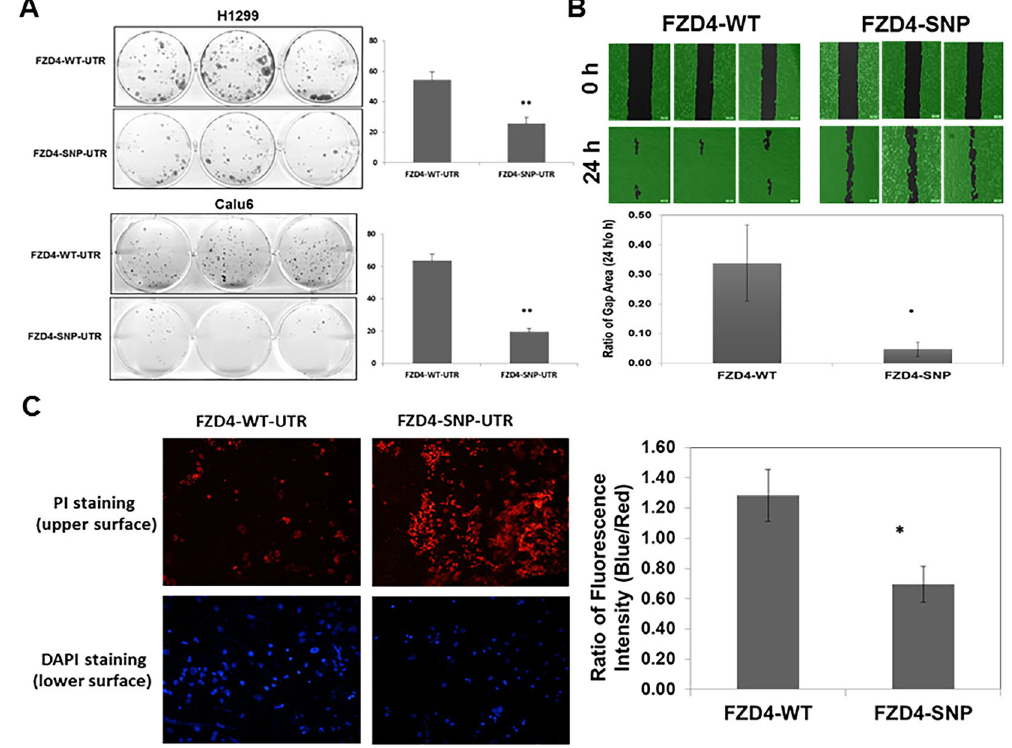
Figure 4. Inhibition of tumor colony formation and cell migration by FZD4-miR-SNP in NSCLC cells. (A) The rs713065(C) allele reduces tumor cell induced-clonogenesis in C/C homozygous H1299 cells as well as C/T heterozygous Calu6 cells transfected with the FZD4-3 ′ UTR-SNP plasmid, compared with those transfected with the FZD4-3 ′ UTR-WT expression plasmid. * p < 0.05; ** p < 0.001. (B) FZD4-3 ′ UTR-SNP inhibits H1299 cell mobility compared with mobility in cells transfected with the FZD4-3 ′ UTR-WT plasmid. Wound healing of cultured H1299 cells using phase contrast. Photomicrographs were taken at 0 h and 36 h. (C) Inhibition of tumor cell migration/invasion in H1299 cells transfected with FZD4-3 ′ UTR-SNP or FZD4-3 ′ UTR-WT plasmids by a FluoroBlock membrane assay in transwell Boyden